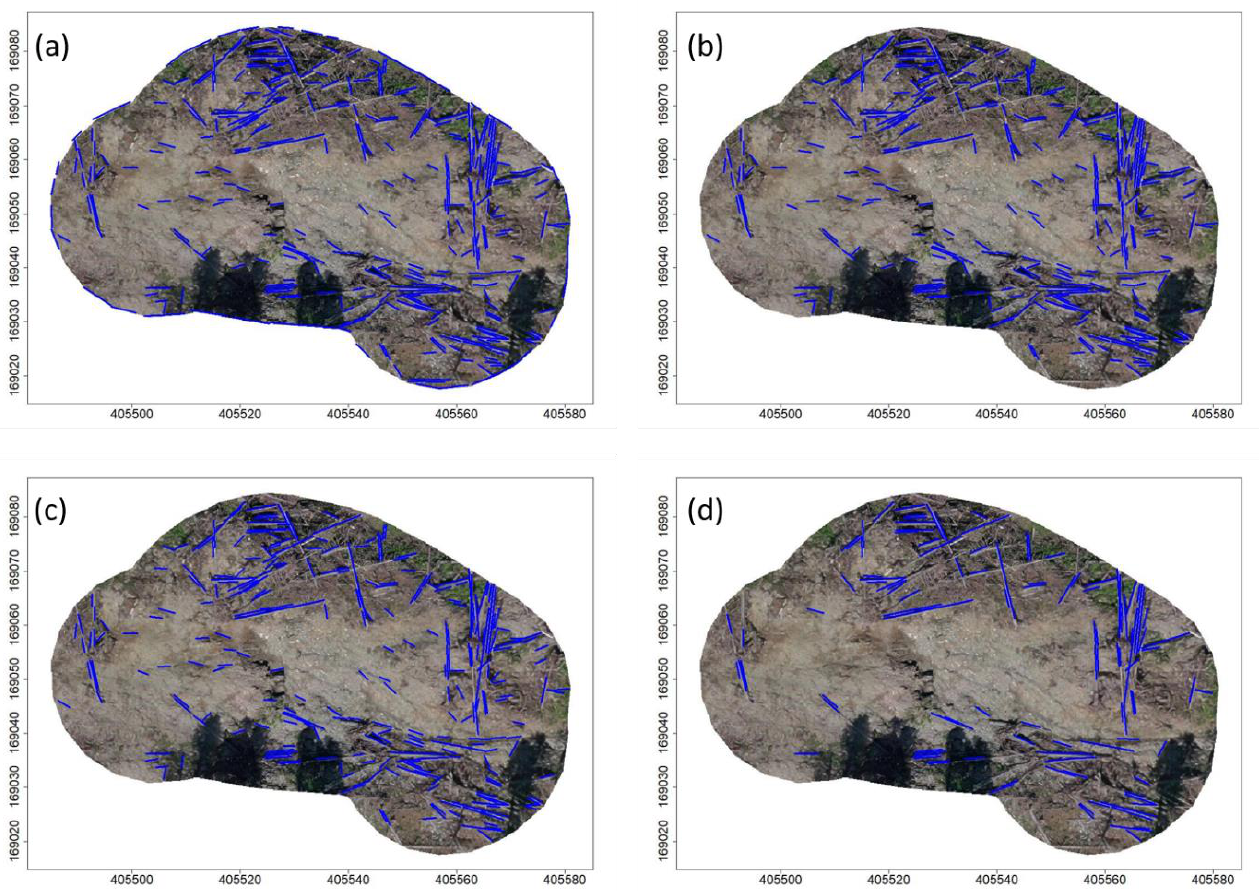
Figure 7. Results of the automated stem detection (blue lines) on sample site Frohn_02. Coordinates are in meters and in the “MGI / Austria GK M31” coordinate reference system (EPSG -code: 31258): ( a ) all detected line segments; ( b ) remaining line segments after negative buffering of 0.5 m; ( c ) union of line segments that may belong to one stem; and ( d ) removal of short line segments using Jenks natural breaks classification.